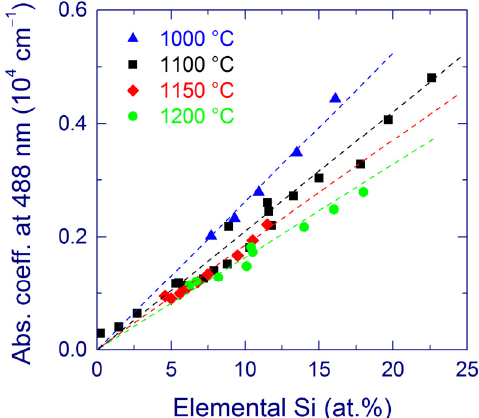
Figure 5. Absorption coefficient at 488 nm for annealing at 1000 °C (triangles), 1100 °C (squares), 1150 °C (diamonds), and 1200 °C (circles) as a function of the amount of elemental Si. The dashed line is a guide for the eye. Reproduced with permission from [116]. Copyright 2012, AIP Publishing